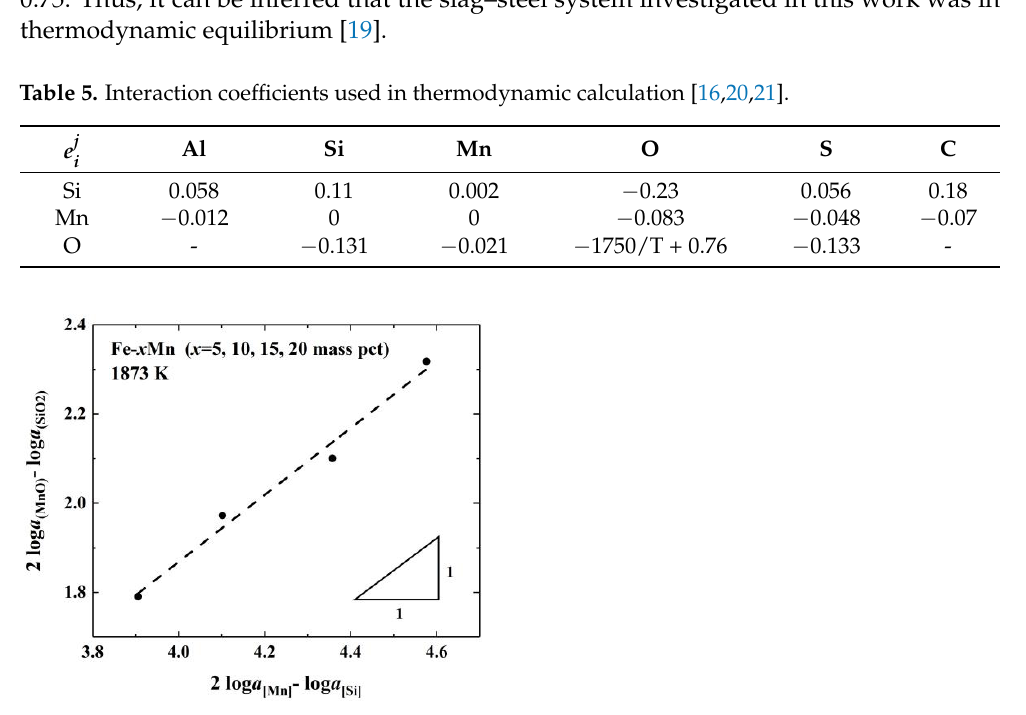
Figure 4. Morphology of typical inclusions after slag–steel reaction: ( a ) MnO; ( b ) MnO-SiO 2 sys- tem; ( c ) MnO-Al 2 O 3 -MgO system. 3.3.2. Effect of Mn Content on Inclusion Type The statistical information of inclusions in steel samples was obtained by ASPEX. Inclusion types change little with Mn content increasing, whereas, the amount proportion of each type changed greatly, as shown in Figure 5. The percentage of MnO type decreased and MnO-Al 2 O 3 -MgO type increased with the increase in Mn content. The contents of Mg, Al, Si, Ca, Mn, and S of the detected inclusions were recounted to the sum of 100%. Figure 6 shows the average mass percentages of main elements in inclusions. It is easily seen that Mn represents the majority in inclusions. With the increase in Mn content, Mn content in inclusions shows a decreasing trend while Al and Mg show an increasing trend.